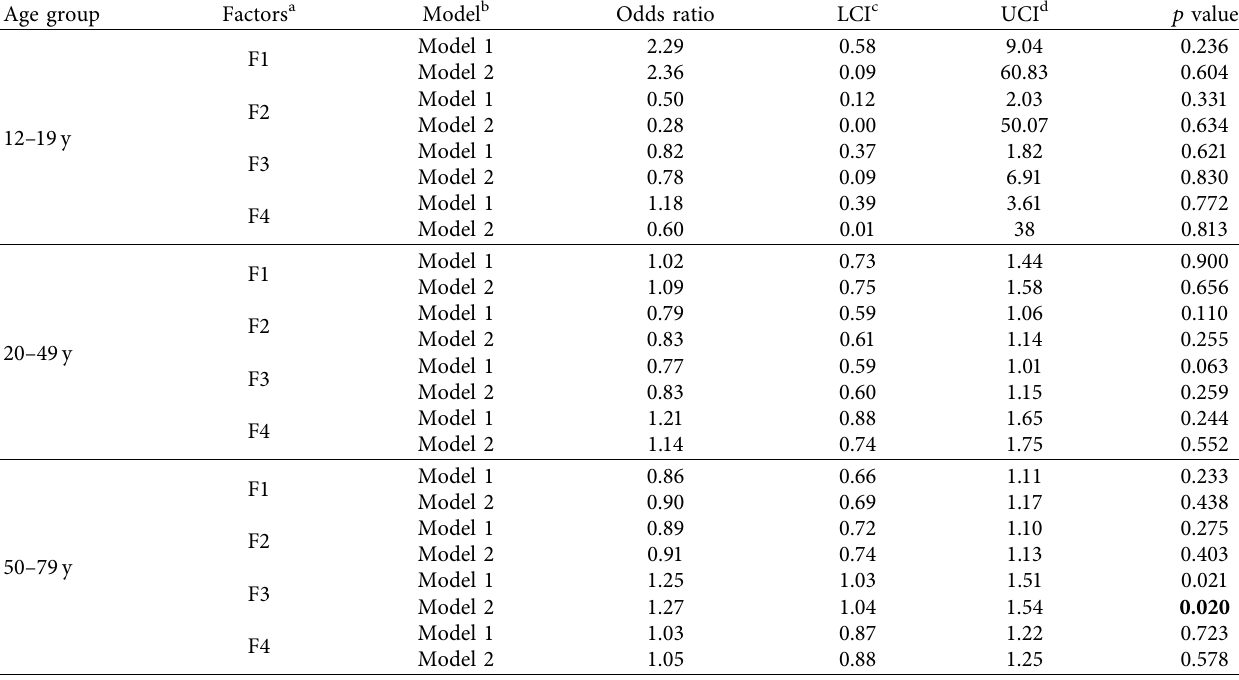
Table 3: Multivariate-adjusted odds ratios for the association between metabolic syndrome and dietary patterns (factors) by age group, Canadian Health Measures Survey combined Cycles 1 and 2,